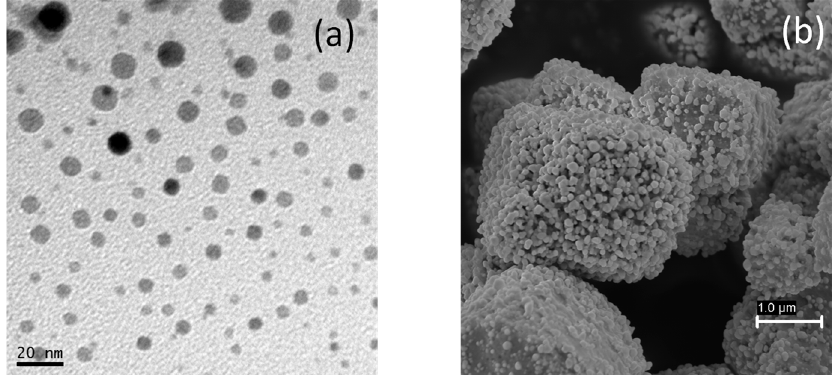
Figure 4. AgCl nanoparticles characterization: ( a ) TEM image, ( b ) SEM image.